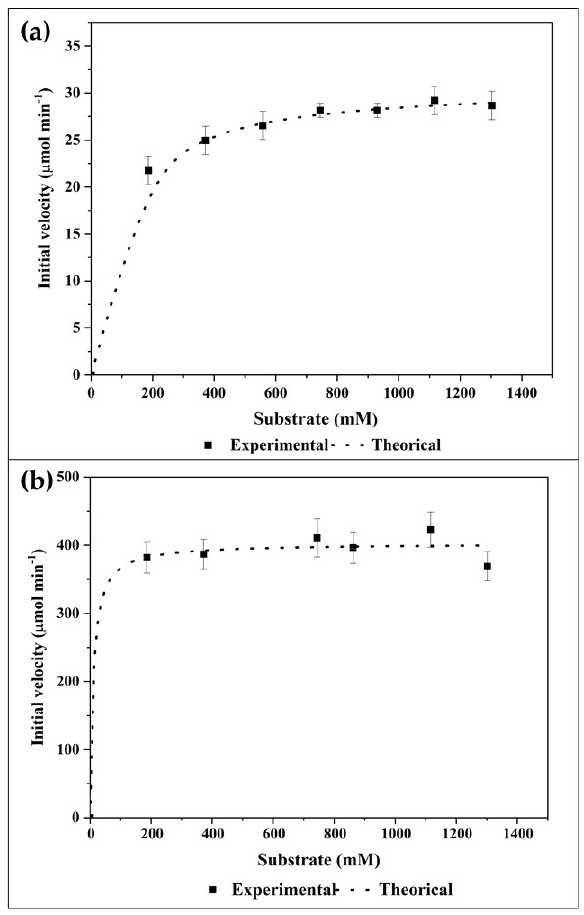
Figure 7. Hyperbolic Michaelis-Menten regression of A. japonicus lipase ( a ) free and ( b ) immobilized in MKSF support, at different concentration of olive oil substrate at 30 °C and pH 8.0. The error bars represent the standard deviation of triplicates.